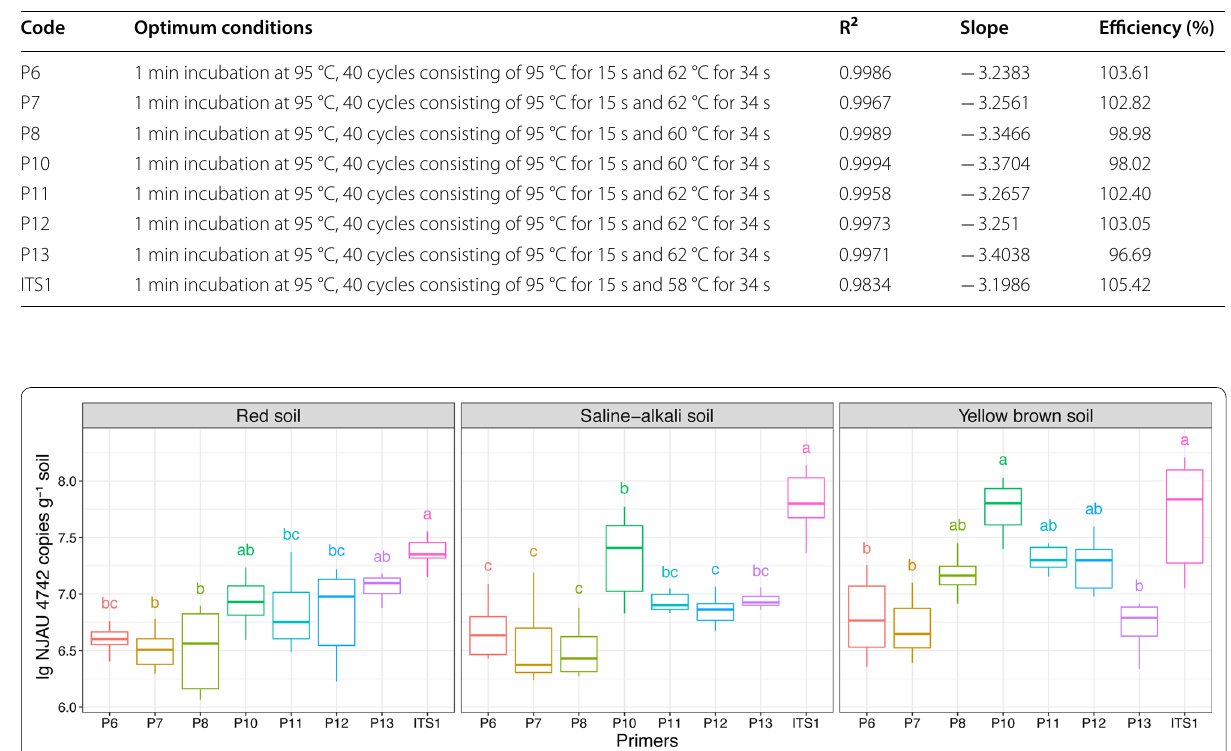
Fig. 1 Amounts of T. guizhouense NJAU 4742 in different soil types by qPCR using different primer pairs. Values are the means of three soil treatment replications using different strain-specific primers. The letters indicate significant differences among the primer pairs as determined by the Tukey